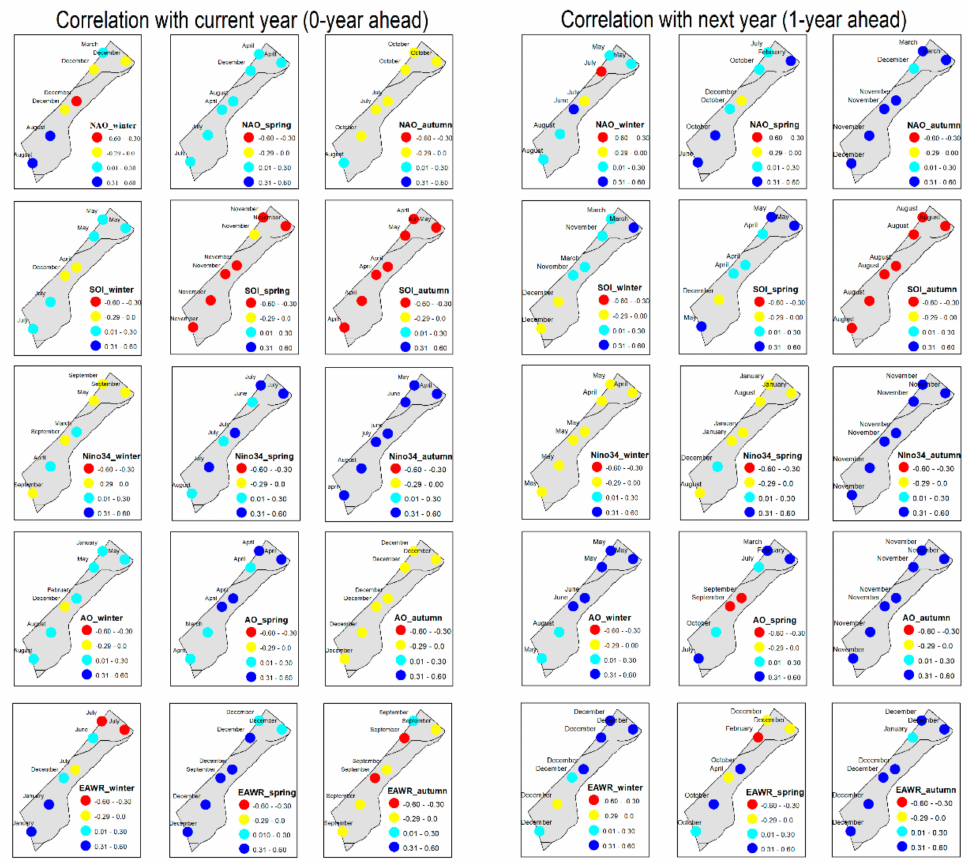
Figure 4. The correlation between the seasonal precipitation over Gaza and the NAO, SOI, Niño 3.4, AO, and EAWR. The left (right) panel shows the correlation with the current (next) year. Labels at the meteorological stations indicate the month, which has the highest correlation with